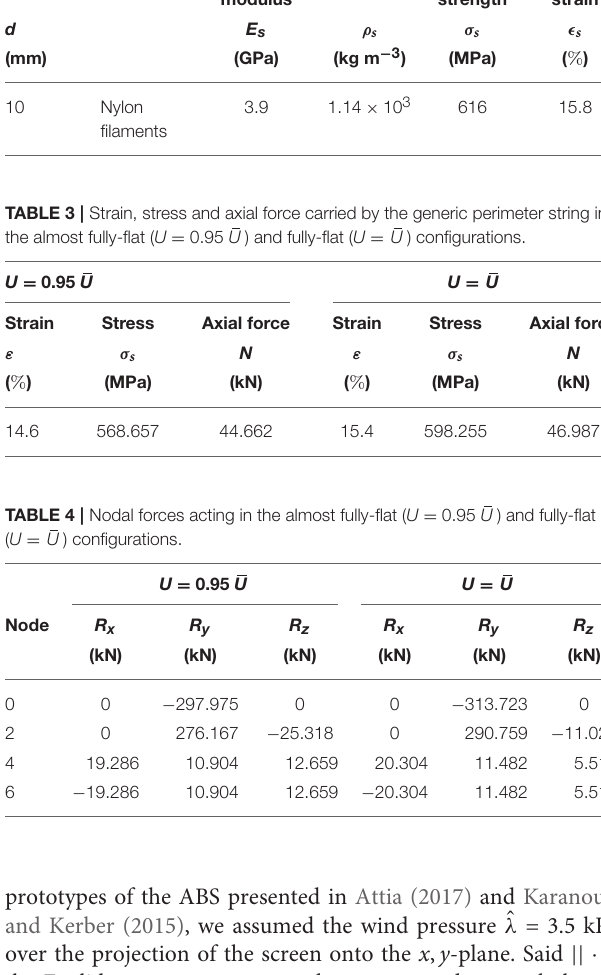
TABLE 2 | Geometric and mechanical (effective) data of (nylon-fiber ropes). Diameter Material